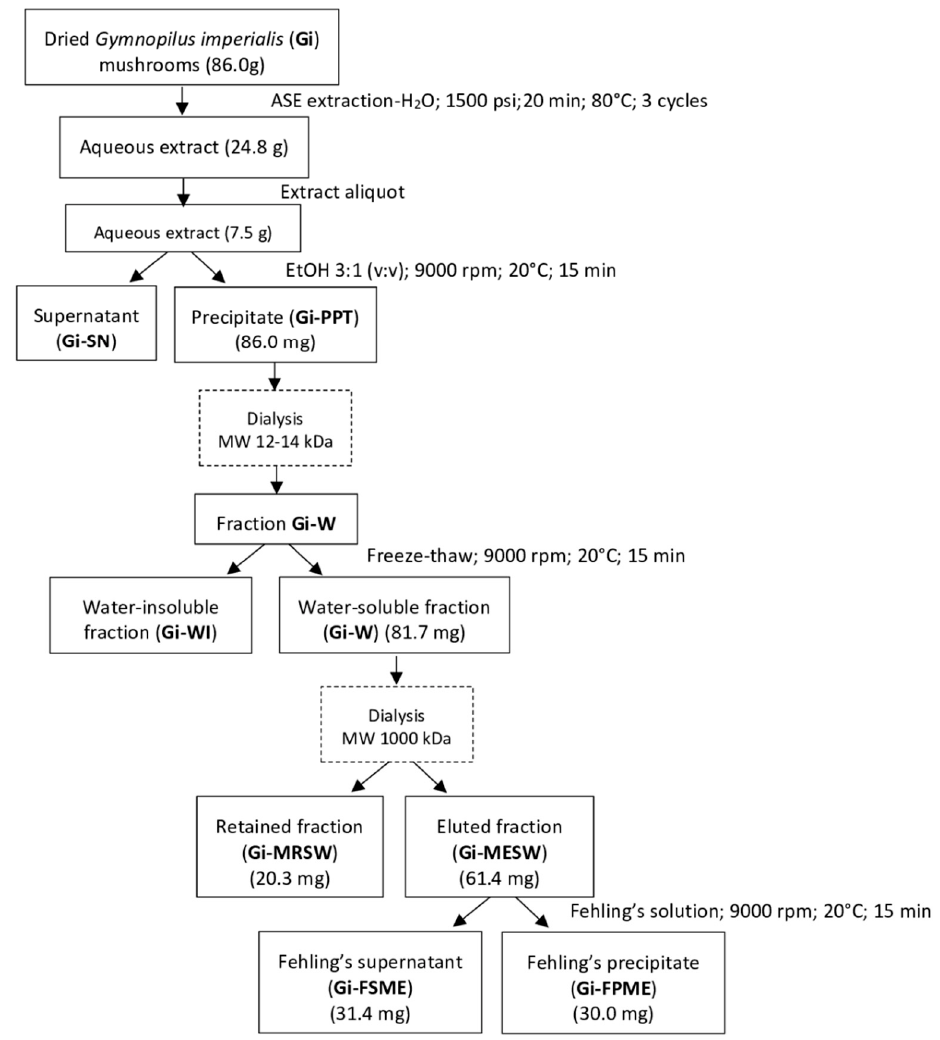
Figure 3. Thegeneralprocedureofpolysaccharidepurificationfromthebasidiomataof Gymnopilusimperialis Figure 3. The general procedure of polysaccharide purification from the basidiomata of Gymnopilus imperialis .